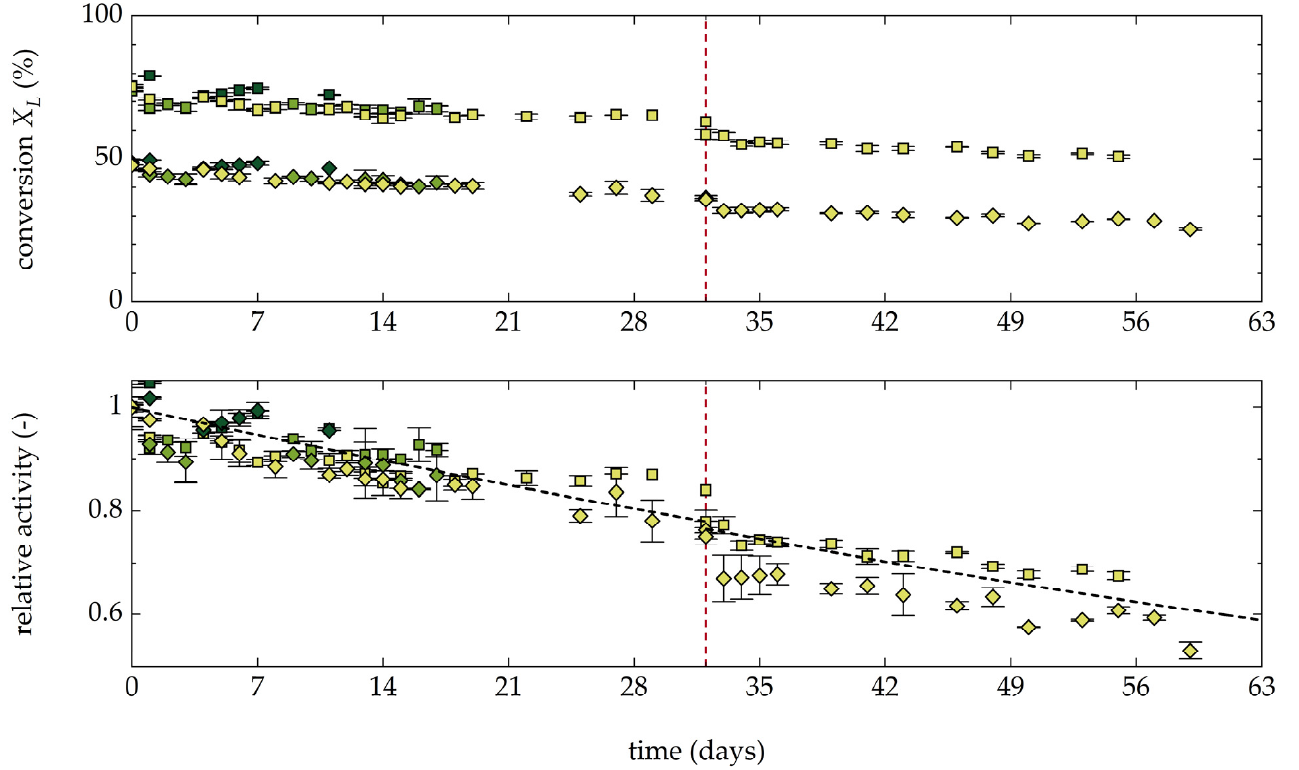
Figure 7. Activity decline of the AAR in an EFBR at room temperature with a constant throughput of 1 mL/min water. The experiment was repeated three times (run 1: 11 days (dark green), run 2: 17 days (medium green); run 3: 59 days (light green)). For the third run, 5 vol% EtOH was added to the eluent from day 32 onwards. The activity was measured with 10 g/L L -Met pumped through the column with a residence time of 0.076 min (1 mL/min, squares) and 0.03 min (2.5 mL/min, diamonds) and the conversions were determined at the column outlet.